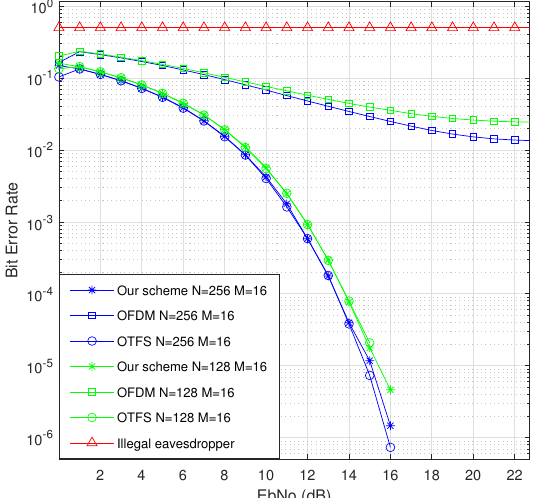
Figure 10. BER for different schemes.